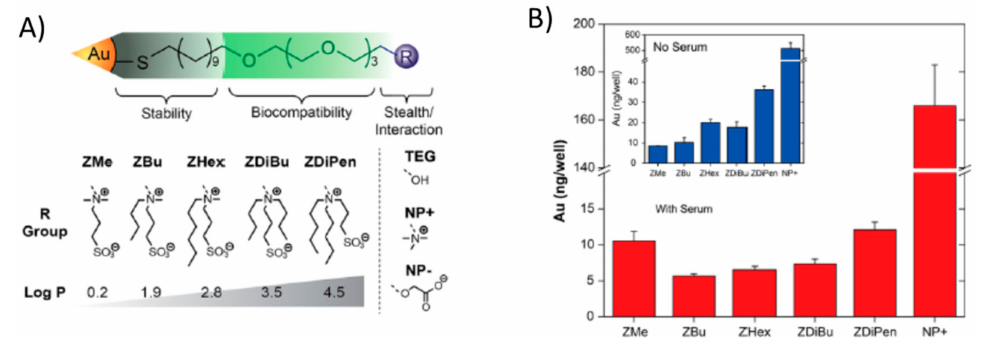
Figure 15. ( A ) Structure of the ligands and zwitterionic / hydrophobic moieties employed. ( B ) Cellular uptake of NPs functionalized with each type of zwitterion in the presence (red) and absence (blue) of serum. Reprinted (adapted) with permission from reference [70]. Copyright (2014) American Chemical